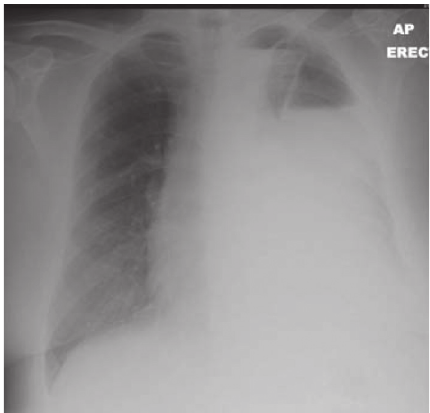
Figure 1: CXR on initial presentation.